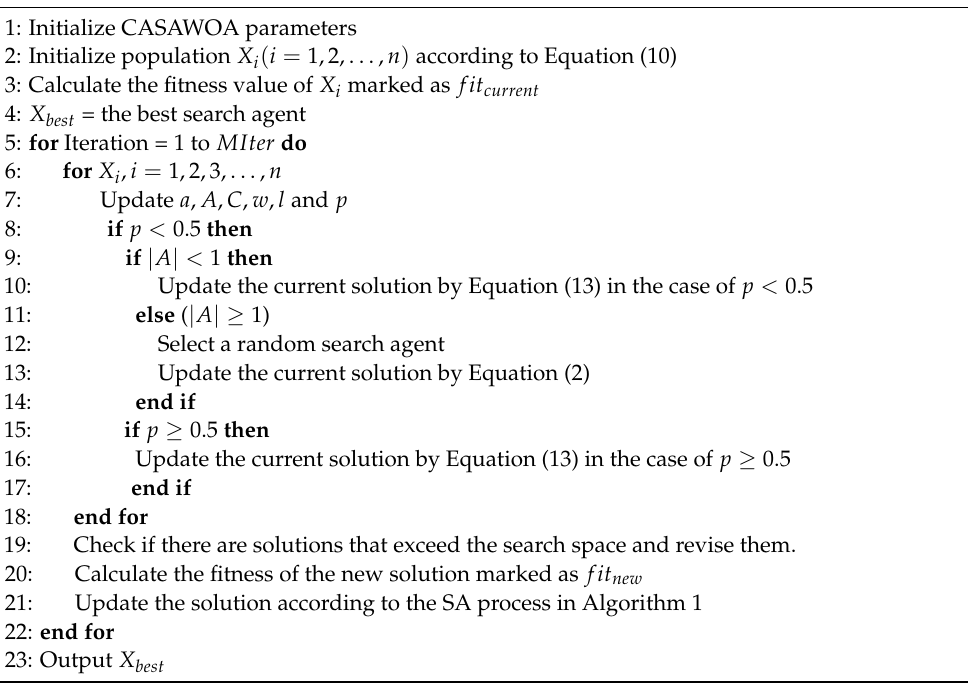
Algorithm 2 The Pseudocode of the